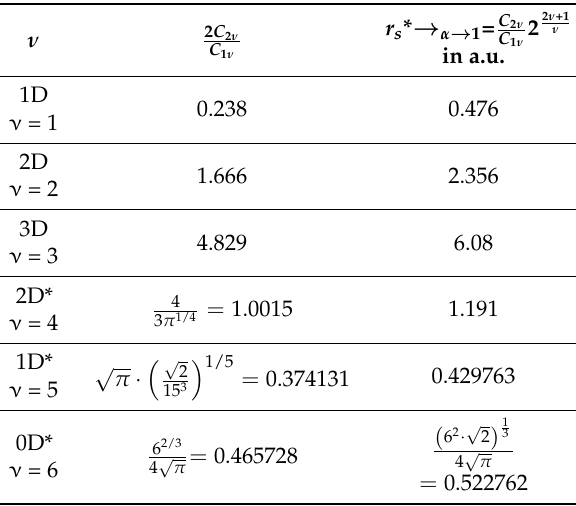
Figure 1. Dependences of the total mean value of the energy per electron E/N as a function of the r s parameter and the polarization degree α for the 3D-, 2D-, and 1D-cases, separately. Table 4. Critical parameter.